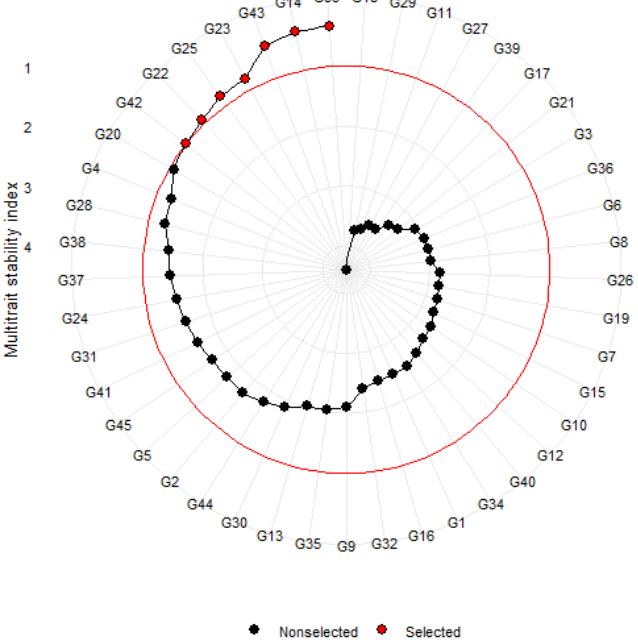
Figure 5. MTSI analysis of tepary bean genotypes for seed yield and days to maturity.